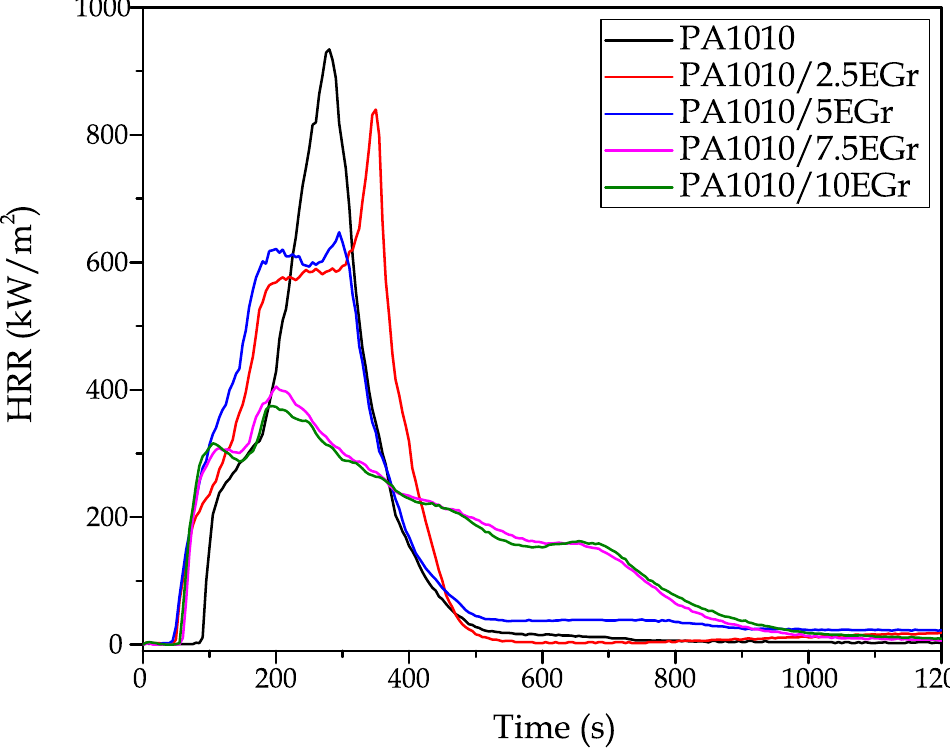
Figure 9. HRR evolution of the PA1010/EGr composites.